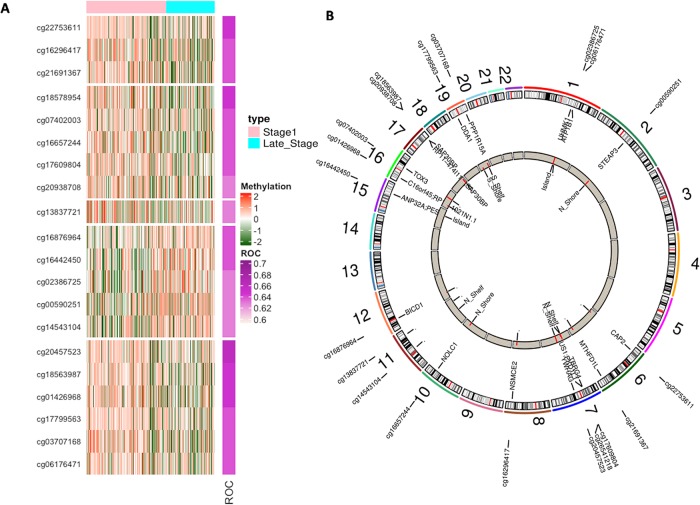
A) Heatmap displaying the differential methylation pattern (with FDR < 0.05) and B) Circos plot representing the chromosome location of top 21 CpG sites (LS-CPG-WEKA) in early versus late stage of LIHC.